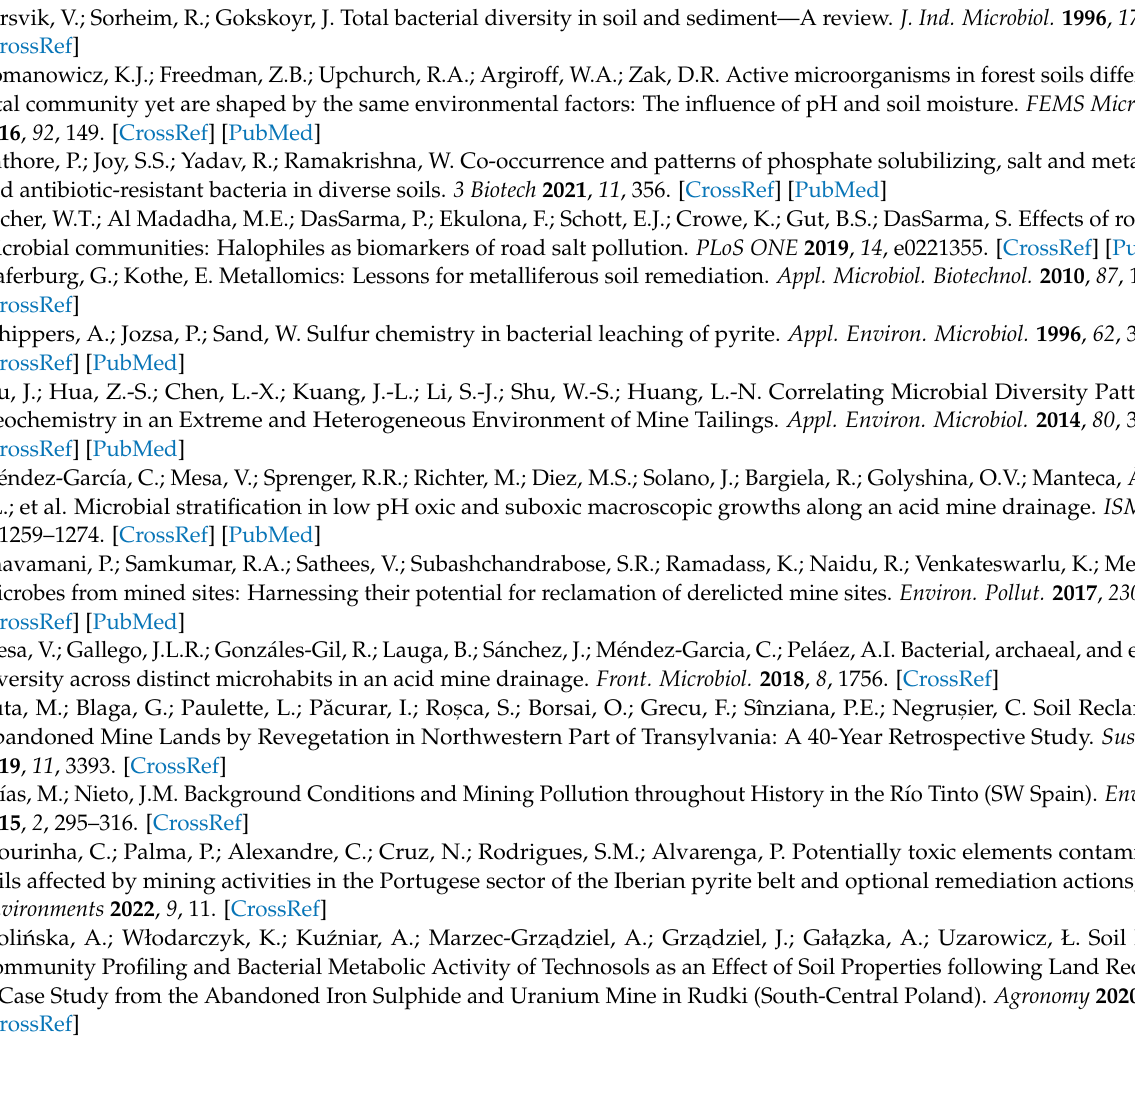
(Germany). Figure S2. Logarithmic plots of real and idealized rank functions. Figure S3. Abundances of five selected OTUs. Figure S4. Logarithmic abundances (r-values) of two selected OTUs. Table S1. Correlation coefficients for the OTUs of the six samples from